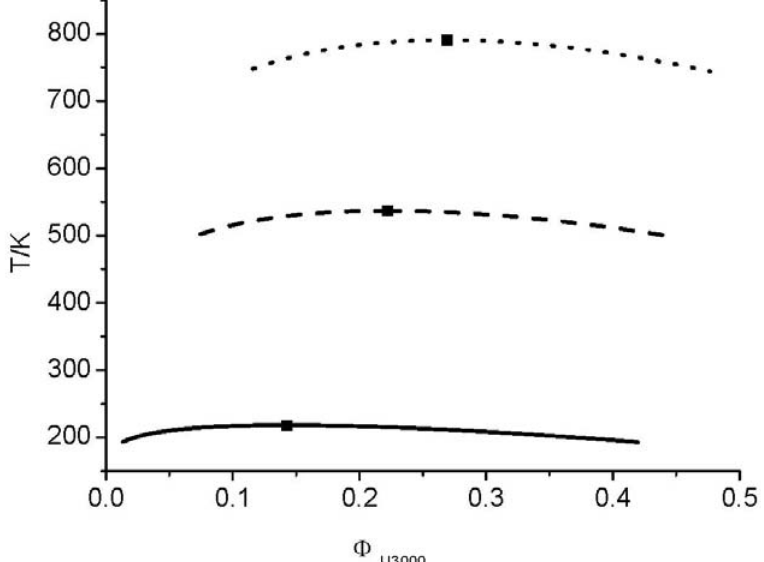
Figure 12. LCT model calculations of the mixing (symbols: critical point, lines: cloud point curves) behaviour of hyperbranched polymer Boltorn U3000 + linear polymers having different segment numbers (solid line: M = 50), where ∆ε / k = 3 K . M 2 B